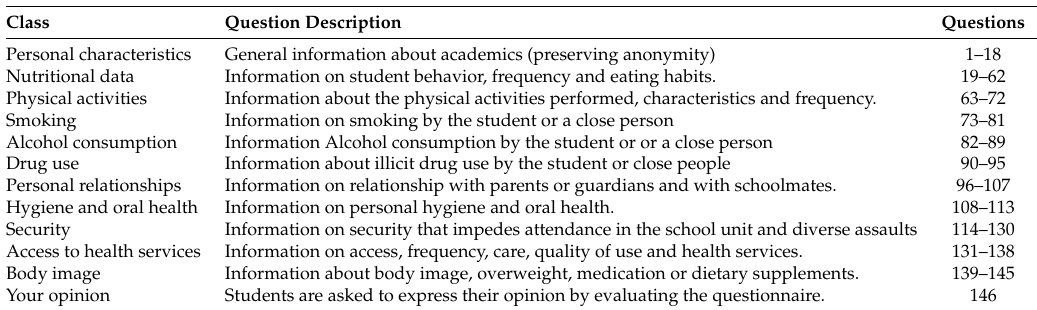
Table 4. Classification of the questions from the questionnaire applied with the students. Source: Table created by the author himself from the National School Health Survey conducted in Brazil in 2015